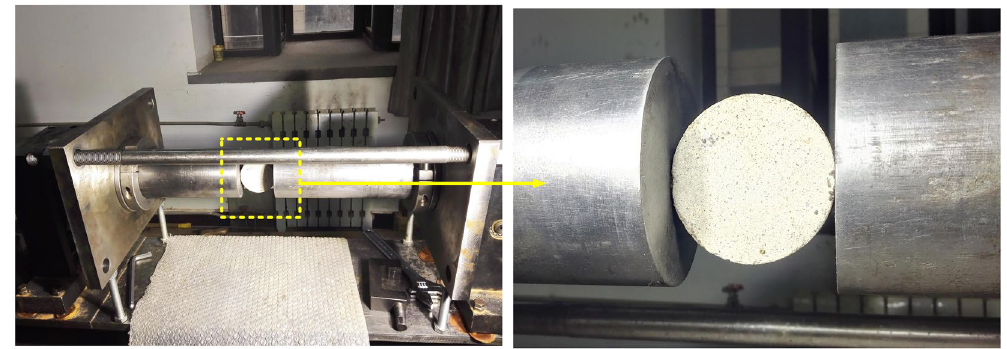
Figure 6. Photograph of a mortar BD specimen in the SHPB